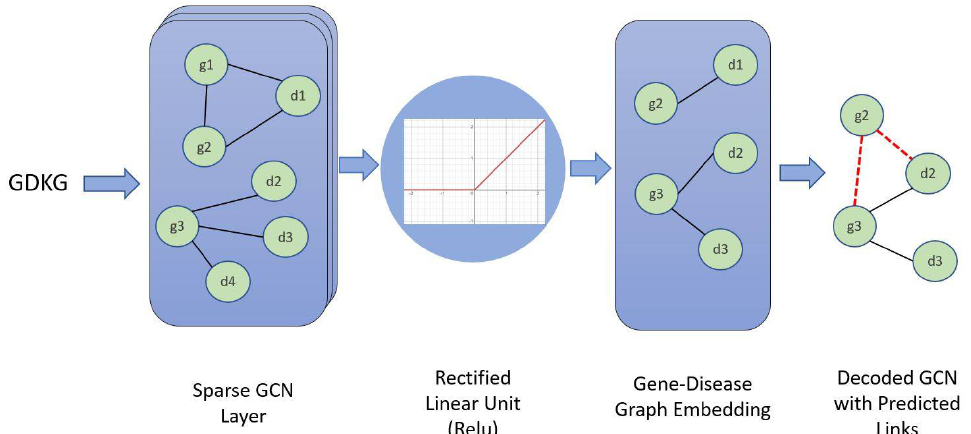
Figure 2. Graph Convolutional Network (GCN) is trained on the GDKG network. Figure shows the sparse GCN layer, ReLu activation function, graph embedding, and the decoded GCN with output predicted links between the genes and disease nodes. g1 and g2 are the gene nodes, d1, d2, and d3 are disease nodes. The output predicted links are shown as red dotted lines.